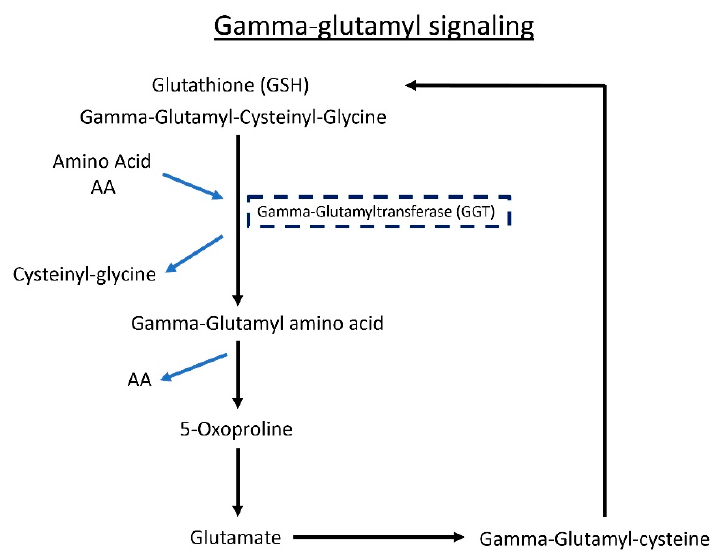
Figure 6. The schematic shows the GGT pathway. Detailed changes of metabolites with or without butyrate treatment are shown in Table 3. Table 3. Butyrate treatment causes shifts in the gamma glutamyl amino acid profile in ALS com- pared to WT mice.